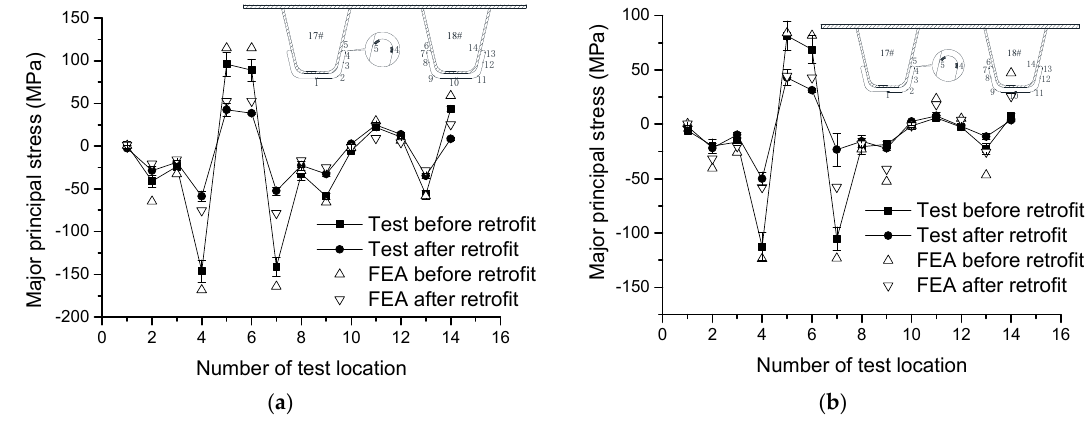
Figure 16. Stress distributions along the edge of diaphragm cutouts: ( a ) longitudinal movement L3, ( b ) longitudinal movement L10.